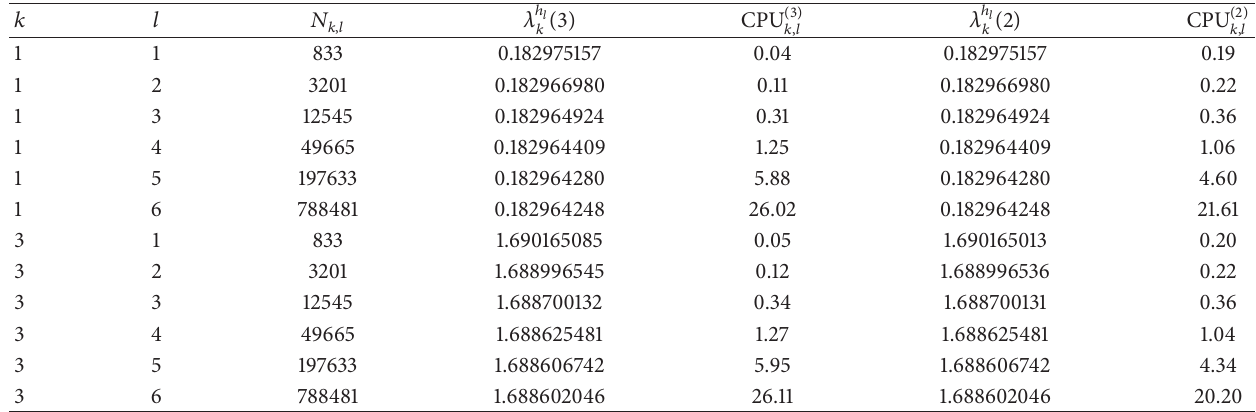
Table 5: The results of Example 4 on Ω = ([0,1] × [0,1/2]) ∪ ([0,1/2] × [1/2, 1])